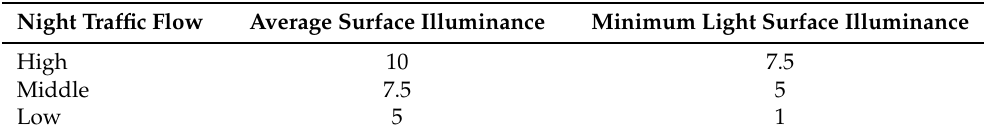
Table 2. Non-motor vehicle traffic (including pedestrians) road-lighting standard values in residen- tial